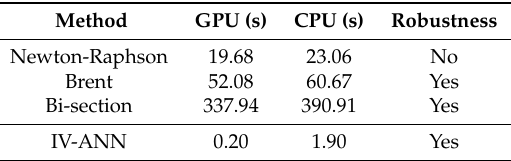
Table 4. Computational cost based on 20,000 option